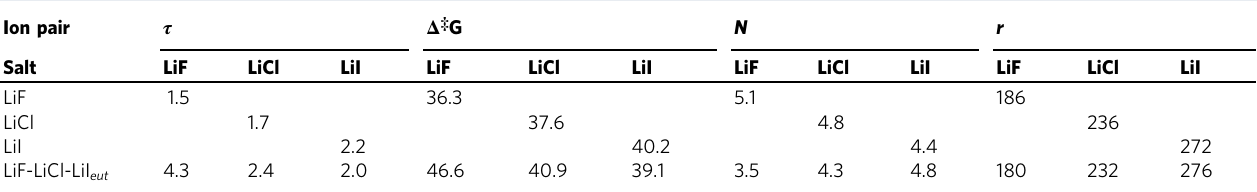
Table 3 Ion-pair lifetimes, thermodynamic and structural data of LiF α Cl β I γ at 1200